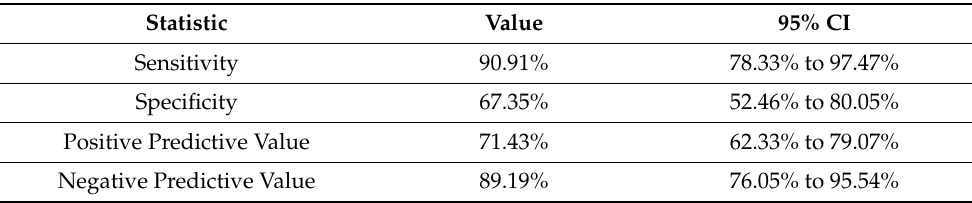
Table 6. Sensitivity and specificity values for HBME-1.